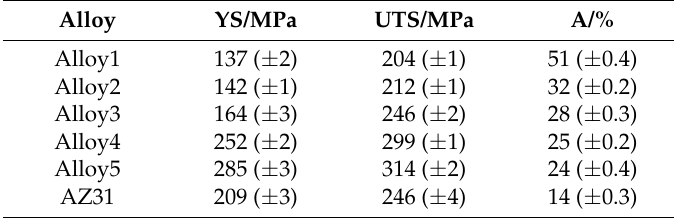
Figure 7. Typical engineering stress-strain curves of the as-extruded alloys. Table 3. Tensile properties of the as-extruded alloys at room temperature.